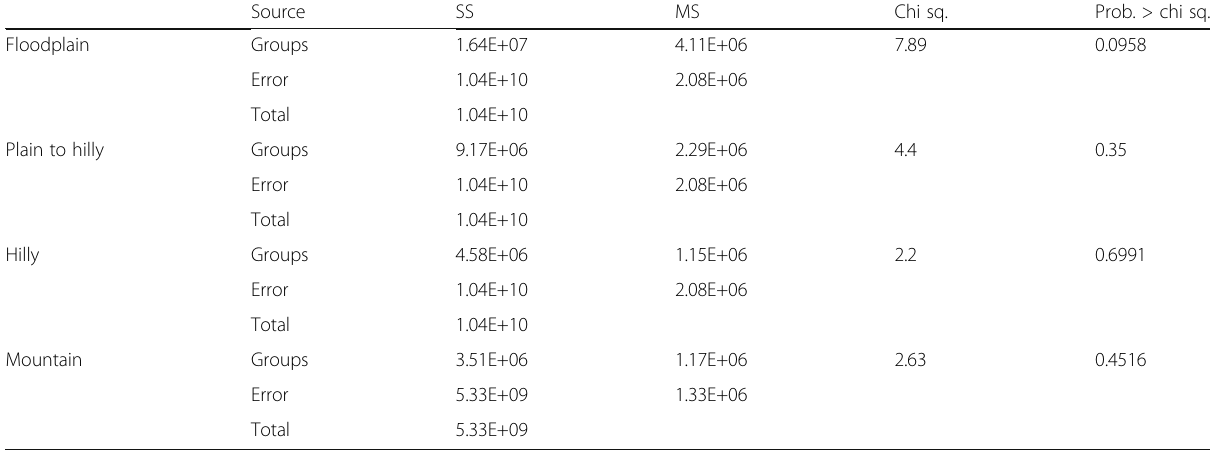
Table 3 Kruskal-Wallis significance tests of mean curvature in each study area based on different land covers